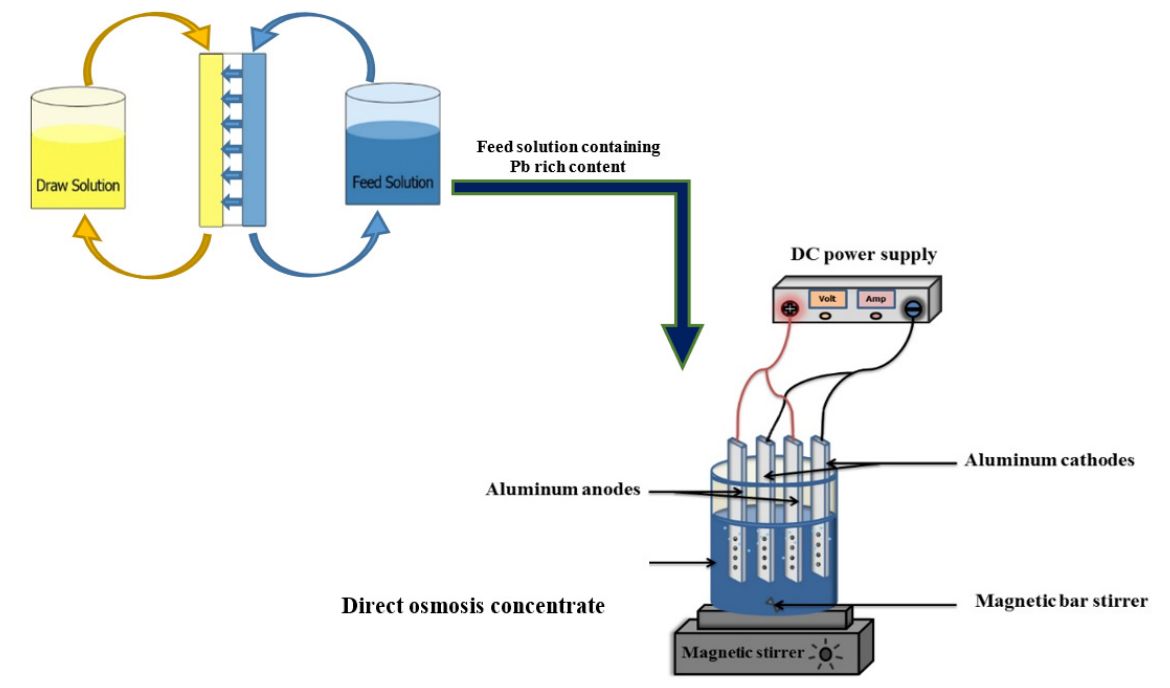
Figure 1. Schematic of the PA-ECF technique to treat DO concentrate containing Pb-rich.